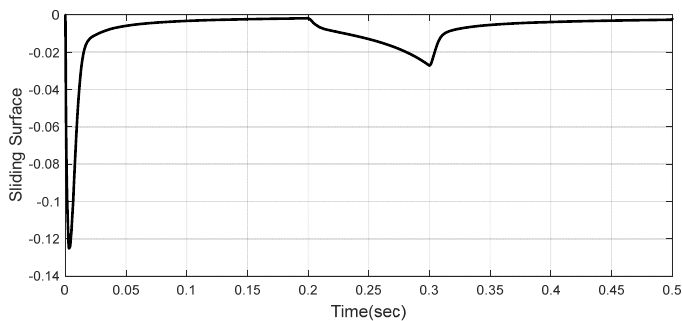
Figure 26. Sliding surface in the presence of measurement noise.